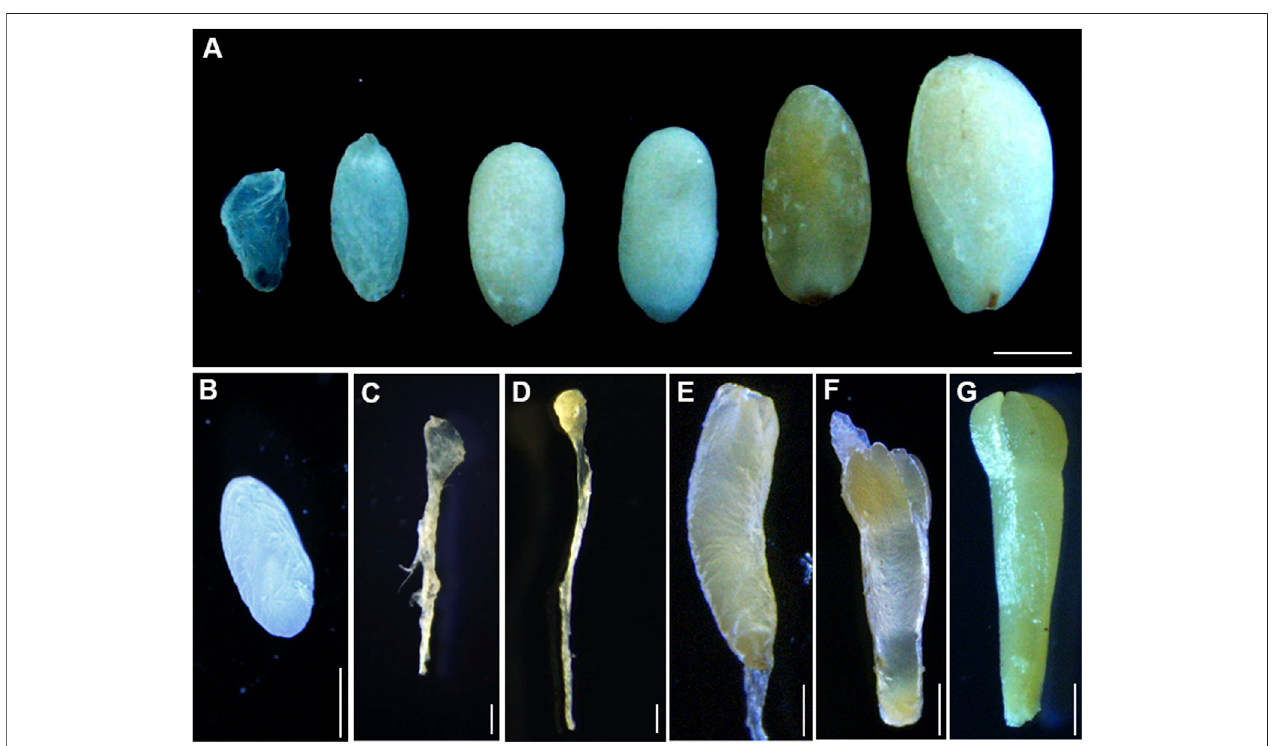
FIGURE1| Developmentstagesofimmaturezygoticembryos. (A) Developingseedscollectedfromopen-pollinatedtreesondifferentdatesafter fertilization.Bars 1 mm. (B – D) Immature zygotic embryo after fertilization. (B) Megagametophy, (C) cleavage polyembryony, (D) dominant embryos, (E) pre-cotyledon embryos, (F) cotyledon embryos, and (G) mature embryos. Bars 0.1